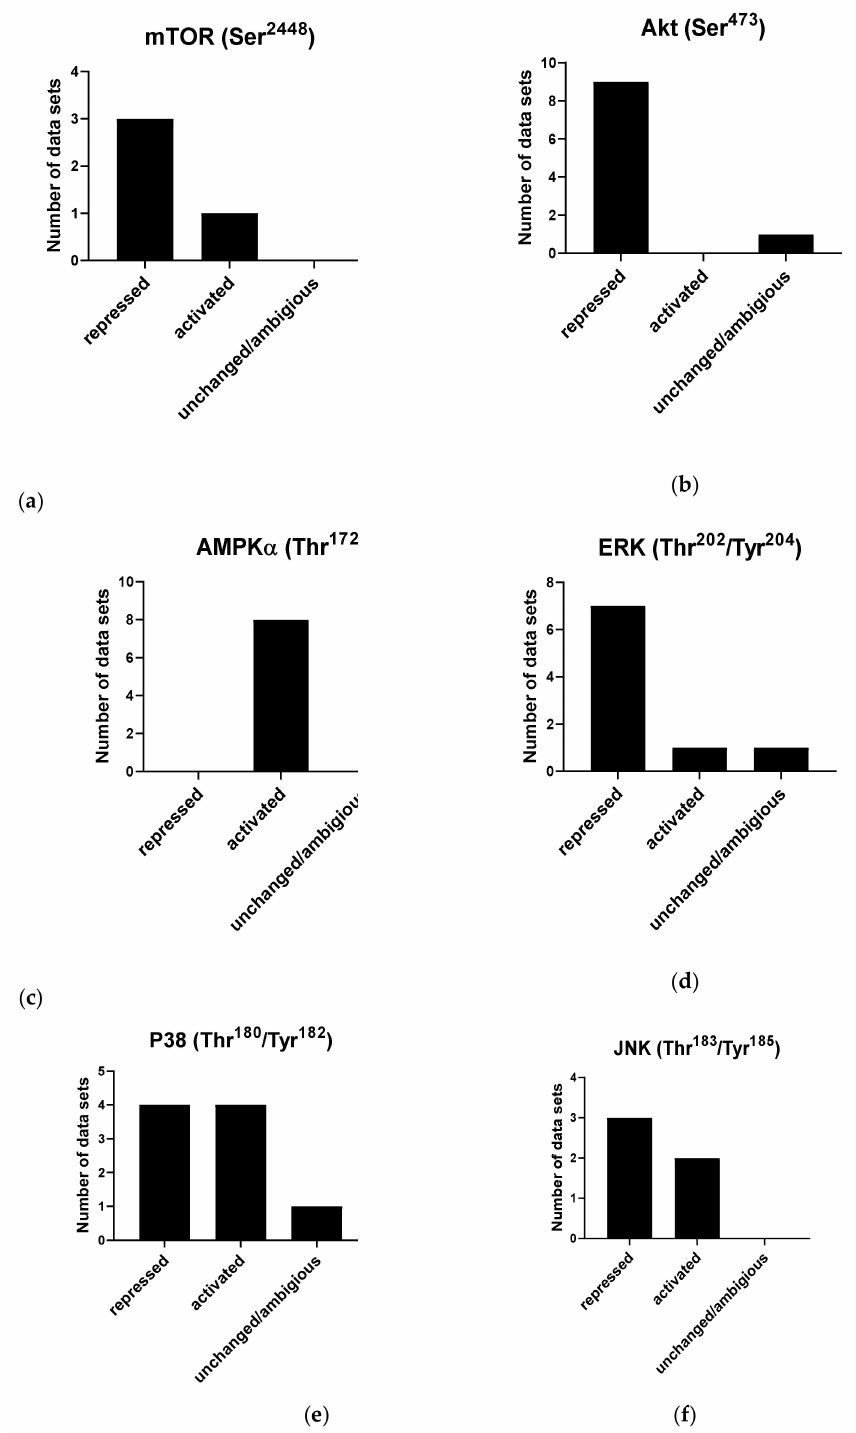
Figure 8. Effects of cordycepin on widely studied signal transduction pathways. Papers were selected as described in the Materials and Methods section and classified according to the effect observed on the indicated phosphorylation sites. ( a ) Effects of cordycepin on the Ser 2448 phosphorylation site on mTOR; ( b ) Effects of cordycepin on the Ser 4738 phosphorylation site on AKT; ( c ) Effects of cordycepin on the Thr 172 phosphorylation site on AMPK α ; ( d ) Effects of cordycepin on the Thr 202 /Tyr 204 phosphorylation sites on ERK; ( e ) Effects of cordycepin on the Thr 180 /Tyr 182 phosphorylation site on the p38 kinase; ( f ) Effects of cordycepin on the Thr 183 /Tyr 185 phosphorylation site on the Jun kinase. The papers from which these data were extracted can be found in Table 1 in the